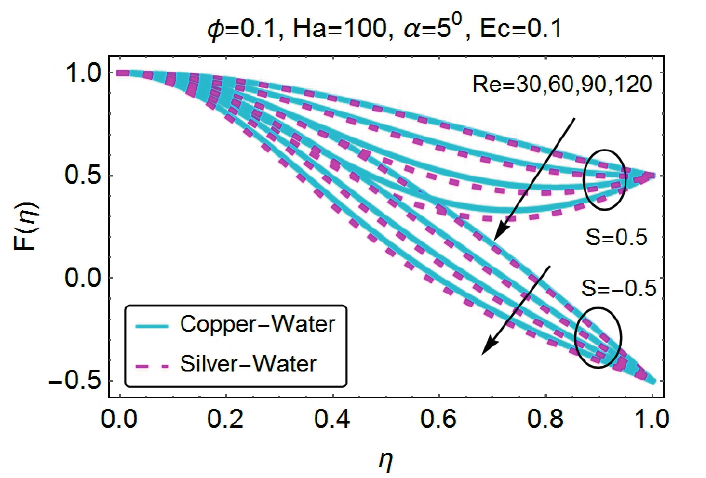
Figure 4. Change in velocity for varying Re (divergent channel).